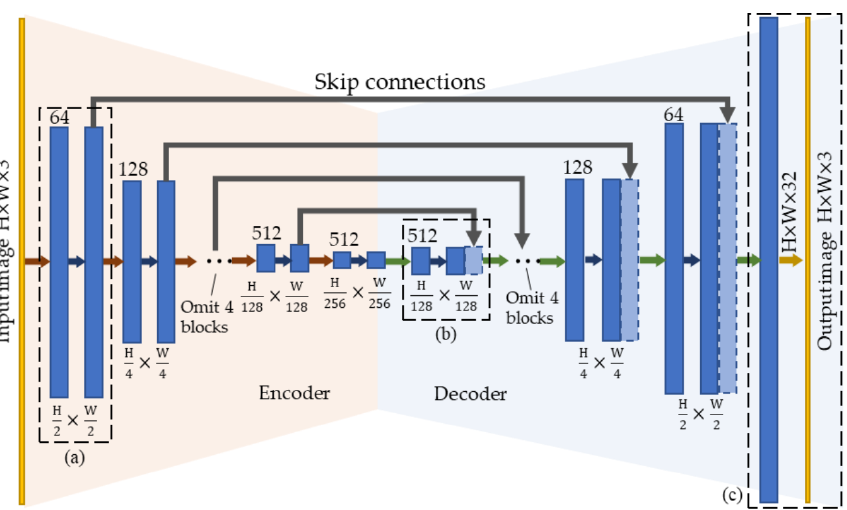
Figure 6. Architecture of the proposed underwater image enhancement network. Dotted-line frame ( a ) is an encoder block, ( b ) is a decoder block, ( c ) is the output block. All encoder blocks have same structure, and so are the decoder blocks but the last output block. Details of the encoder block, decoder block, and output block are given in Figure